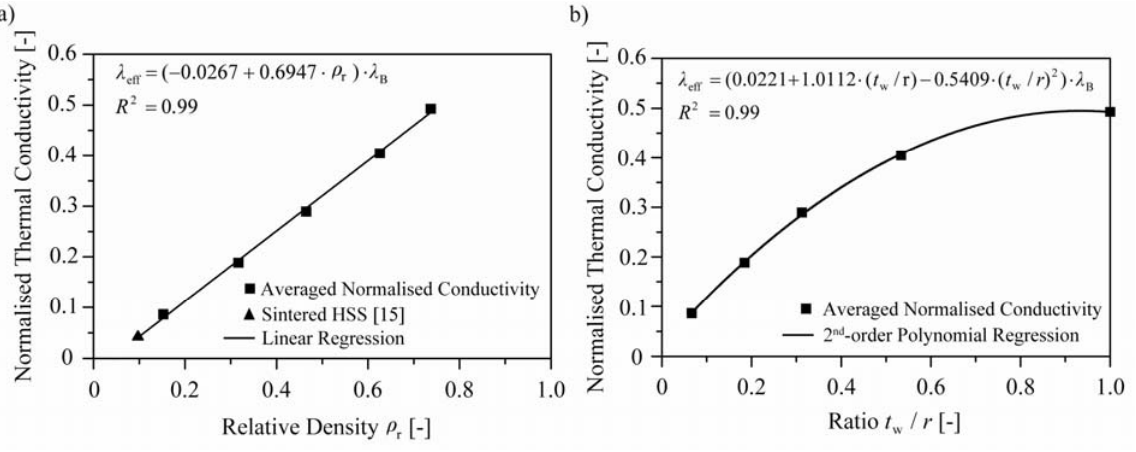
Figure 4. ( a ) Normalised thermal conductivity vs. relative density; ( b ) Normalised thermal conductivity vs. ratio wall thickness to